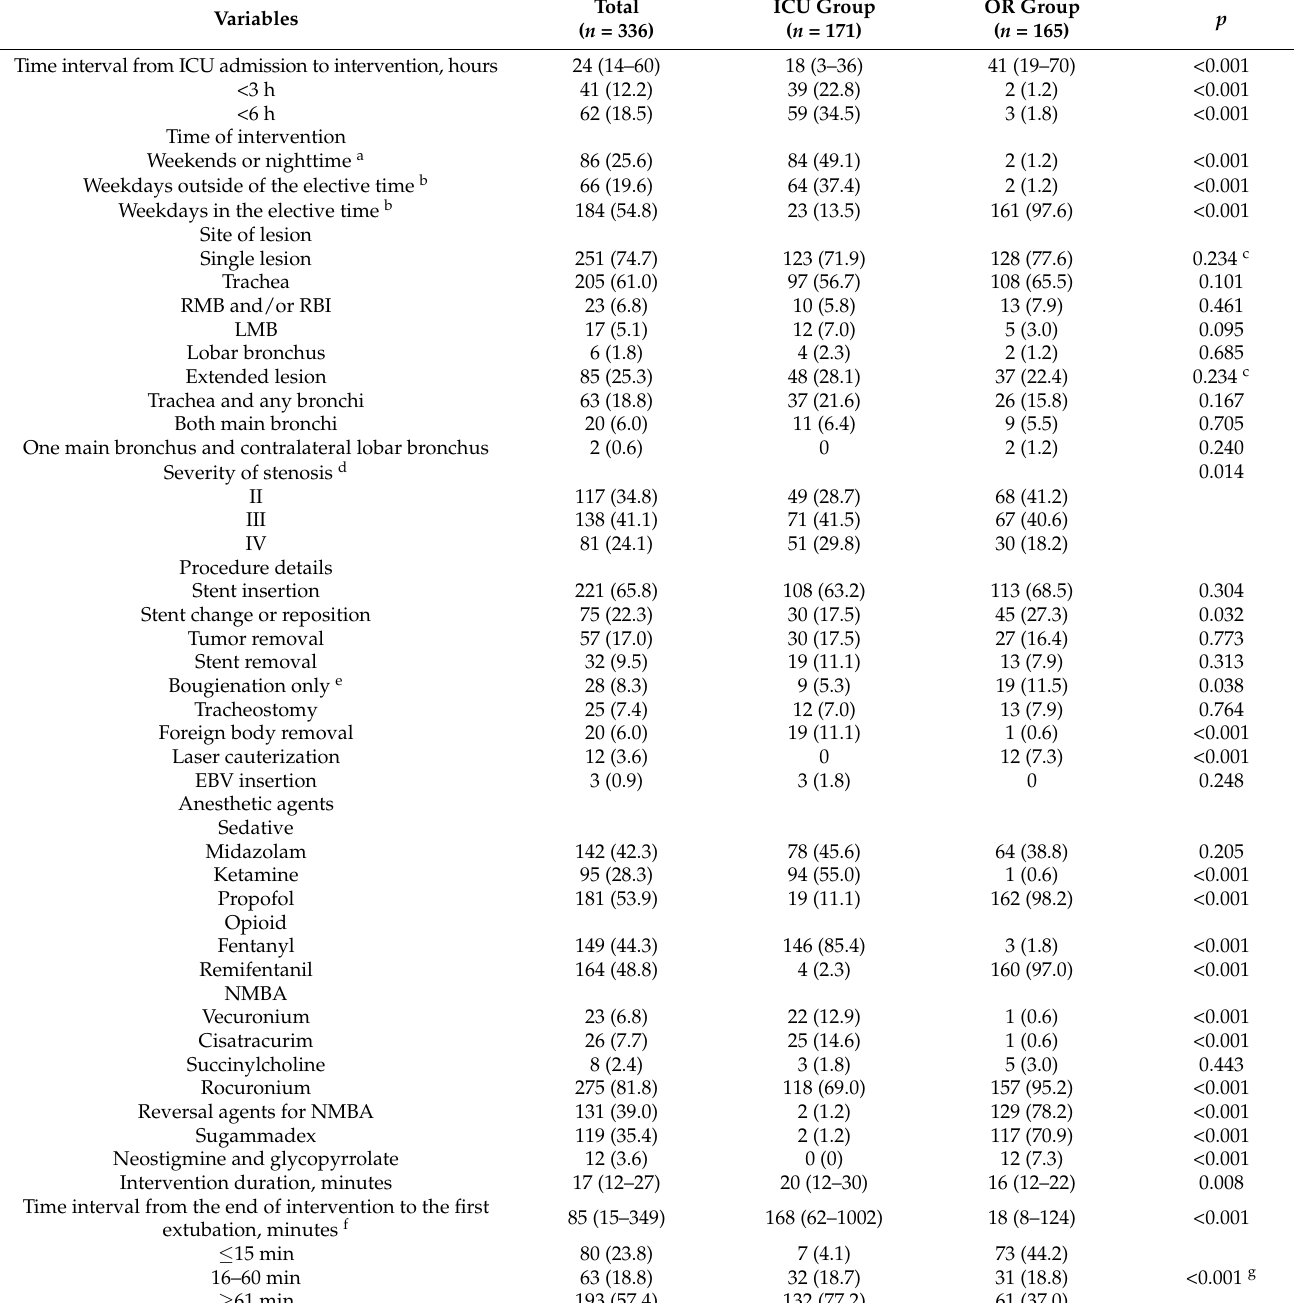
Table 2. Details of rigid bronchoscopy and anesthetic